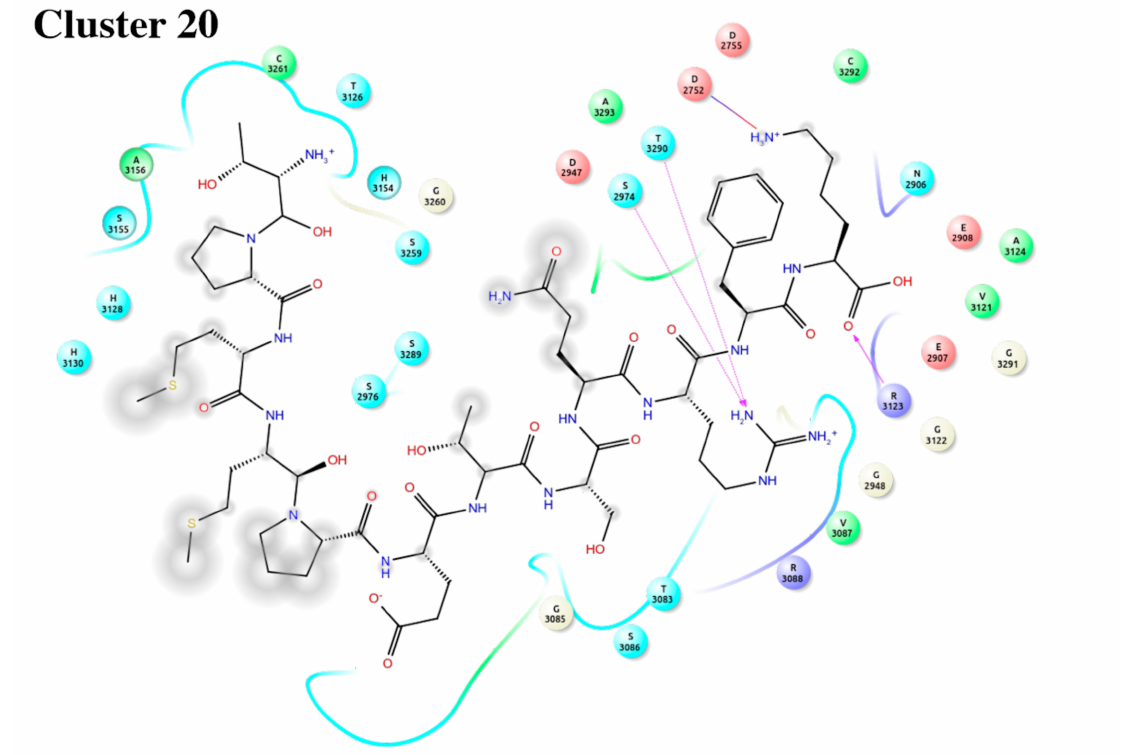
Figure 5. Interaction 2D diagram of the representative structure for both significant clusters 16 (C-16) and 20 (C-20) with laminin-511. Green circle: aromatic π – π interactions, Red circle: hydrophobic interactions, Blue circle: hydrogen